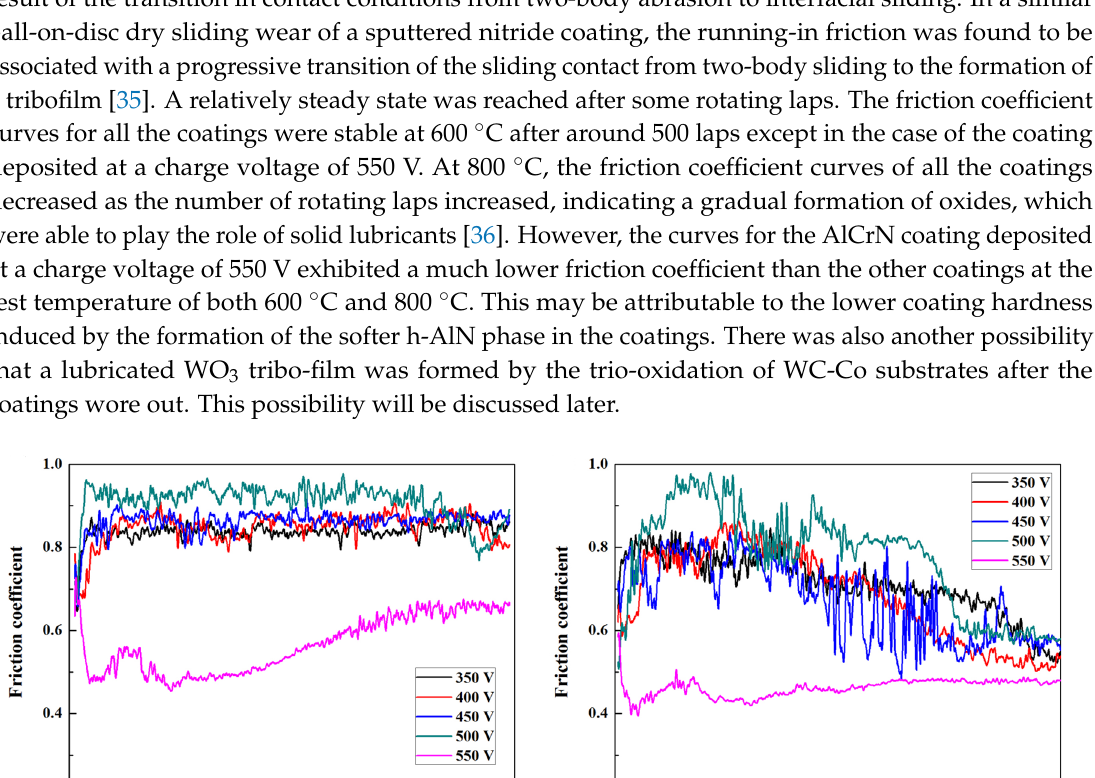
Figure 9. The evolution of the hardness values after vacuum annealing at 600, 800 and 1000 °C for 2 h for AlCrN coatings deposited at different charge voltages.